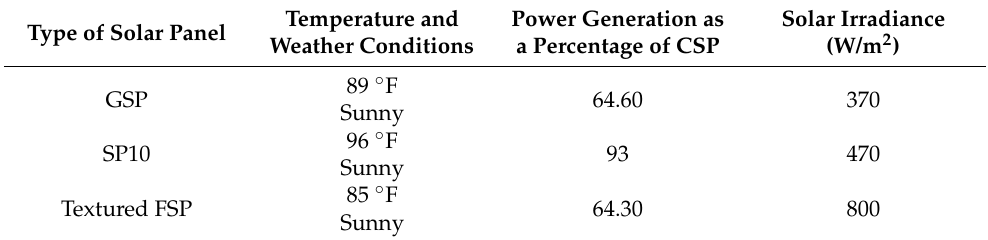
Table 7. Summary of power generation in comparison to control solar panel. Type of Solar